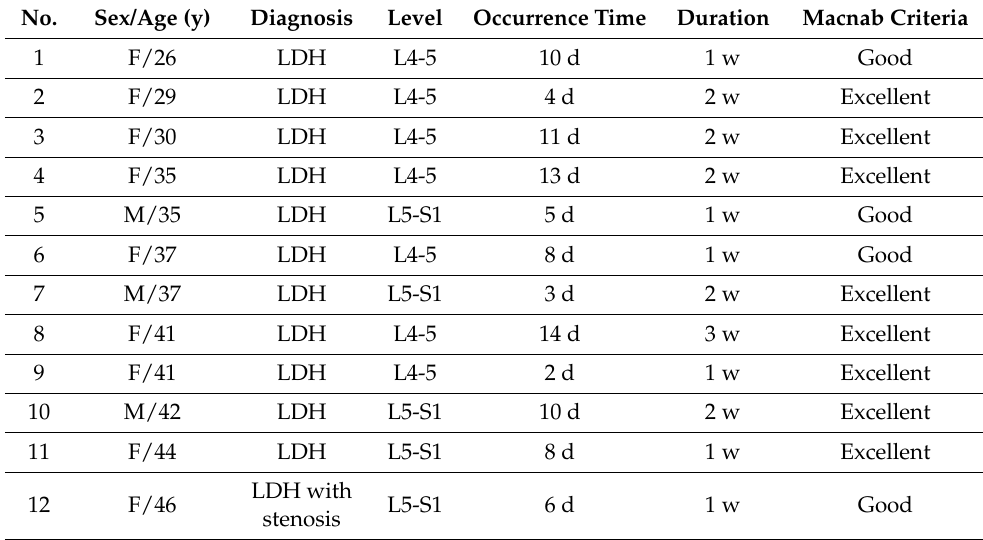
Table 2. Characteristics of patients in the rebound pain group.